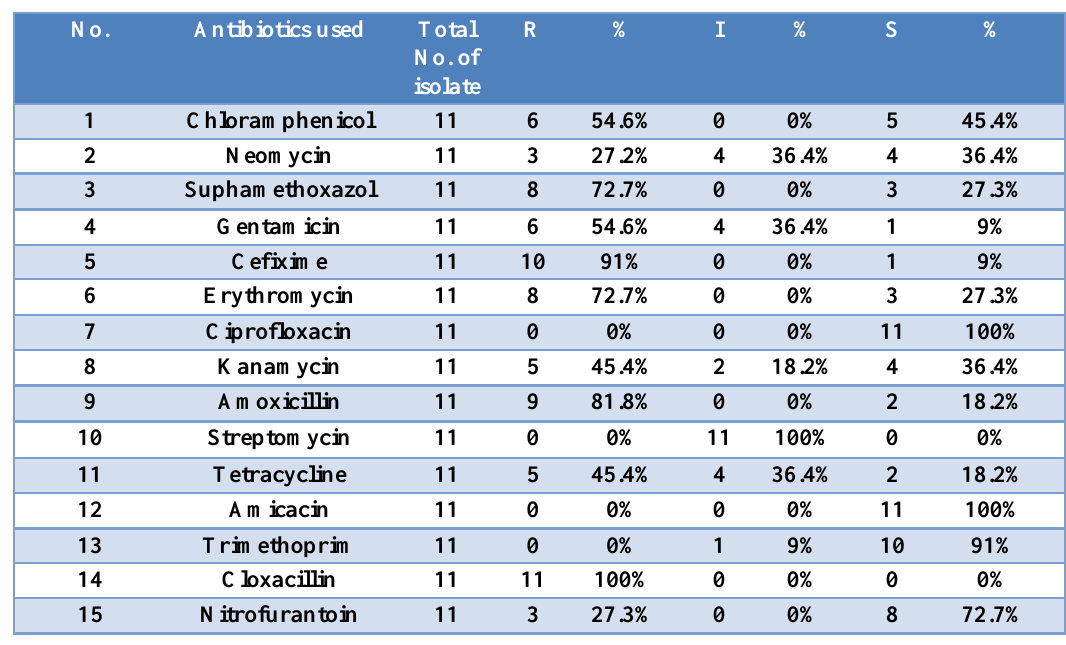
Chi = 0.7non-significant difference between male and female. Table, 6: Antibiotic susceptibility pattern of